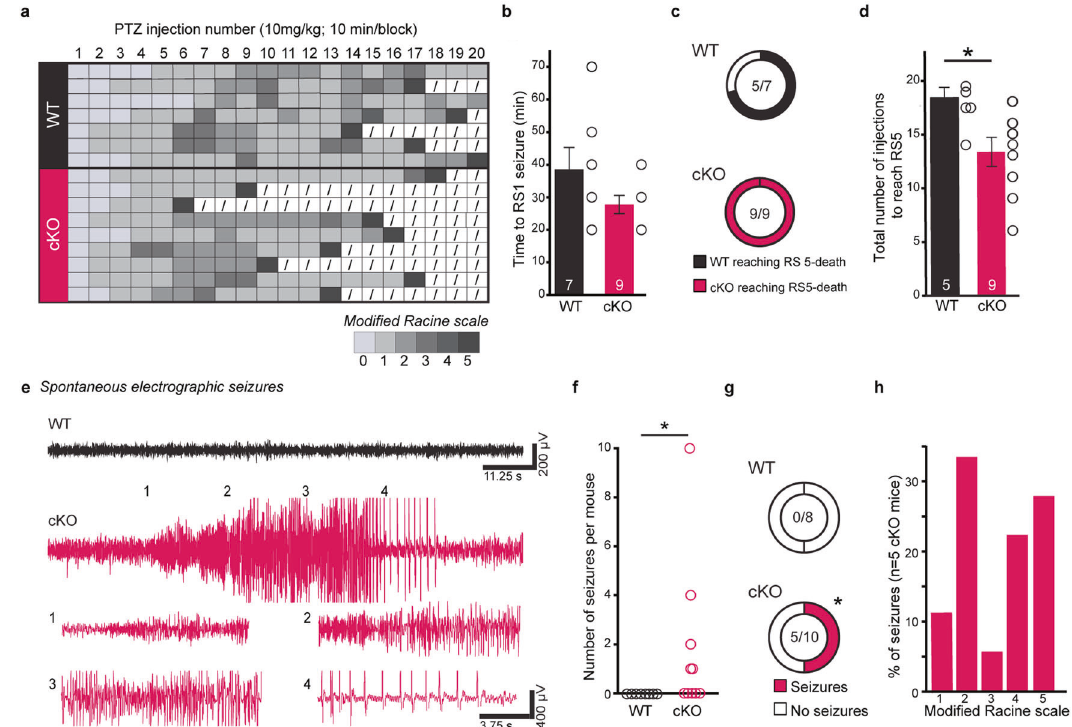
Fig. 6 Nrxn2 cKO mice exhibited higher susceptibility to chemically evoked seizures and develop spontaneous reoccurring behavioral seizures. a – d Nrxn2 cKO mice were susceptible to pentylenetetrazol (PTZ)-induced seizures and seizure-related death. a Diagram illustrating Racine Stage (RS) response and mortality of WT and Nrxn2 cKO after PTZ injections. Each row indicates an individual mouse, and columns indicate the injection number. RS response (0 – 5) is represented by shades of gray. “ / ” indicate no further injections due to death. b The fi rst seizure-related behavior (RS 1) observed, c total number of mice that reached RS5 (death) by 20 injections, d summary graph of total number of PTZ injections to induce generalized seizures (RS5). e – h Nrxn2 cKO mice exhibit unprovoked spontaneously reoccurring seizures. e Representative traces of EEG. Nrxn2 cKO traces show unprovoked electrographic seizures (total seizure duration = 64 s). Insets: Enlarged EEG traces showing classical electrographic seizure characteristics (evolution of EEG activity with >two-fold increase in amplitude and frequency). See Supplemental Video 2 for timestamped behavioral seizures. f Summary graph of total number of seizures. g Number of mice with spontaneous electrographic seizures ( fi lled) or without spontaneous electrographic seizures (un fi lled). h Distribution of Racine scale seizure behavior in Nrxn2 cKO mice with spontaneous electrographic seizures. Number of mice is listed inside the bar graphs. Each open circle represents each mouse. Data is represented as means ± SEM from 7 WT and 9 Nrxn2 cKO for ( b ); 5 WT and 9 Nrxn2 cKO for ( d ); 8 WT and 10 Nrxn2 cKO for ( f – h ). Discrepancy in number of WT mice for ( b ) and ( d ) is due to 2 WT mice not reaching RS5 as shown in ( a ). Statistical assessments were performed by two-tailed Student ’ s t -test ( b , d ) or Fisher ’ s exact test ( c , f , g ) by comparing Nrxn2 cKO to WT mice with * p <